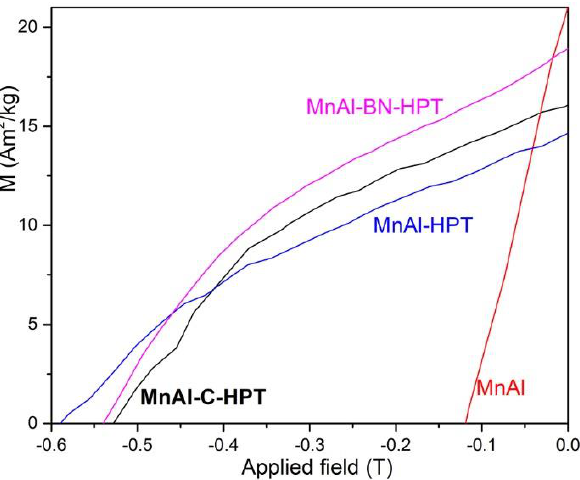
Figure 2. The demagnetization curves of the undeformed MnAl and the HPT-deformed MnAl, MnAl-C, and MnAl-BN,